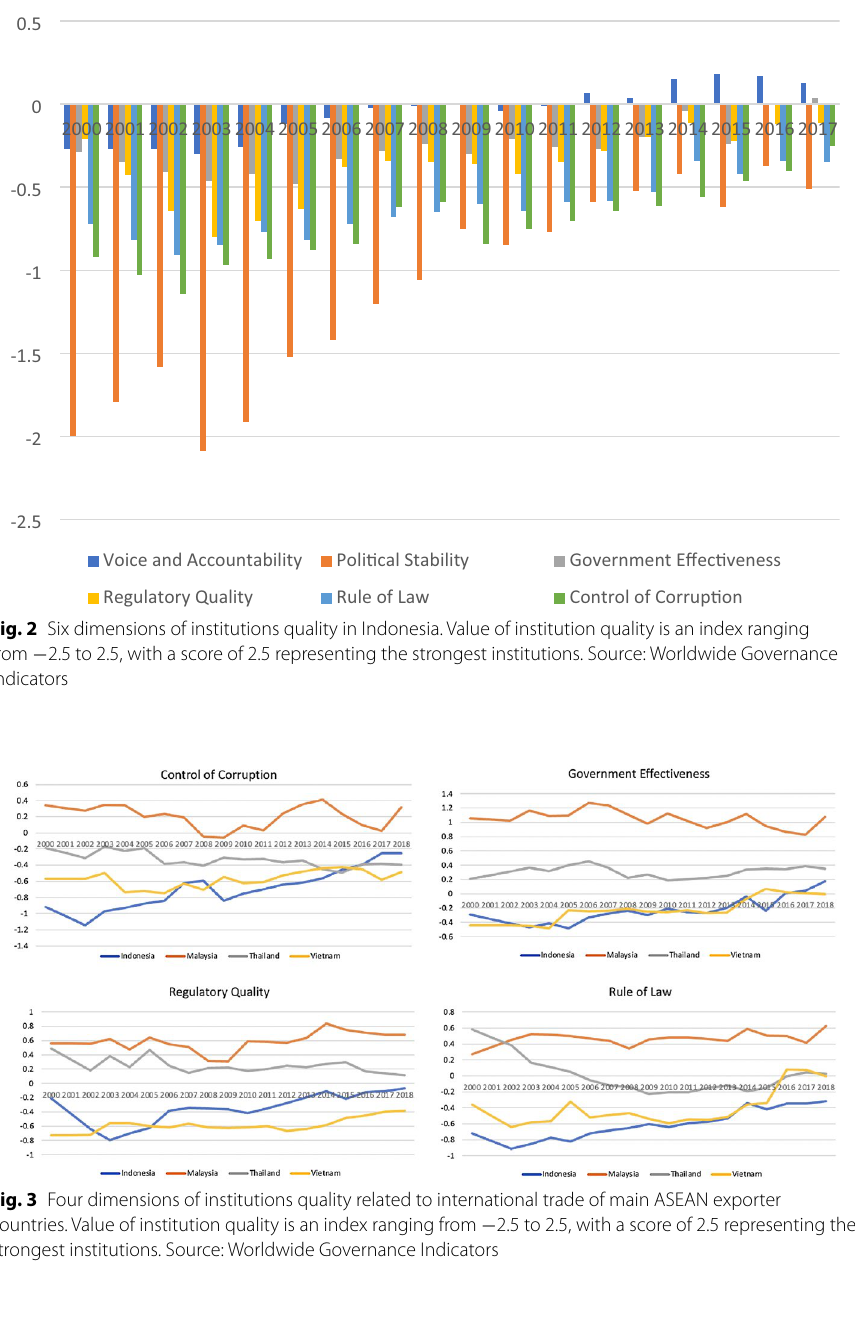
2.5 to 2.5, with a score of 2.5 representing the −